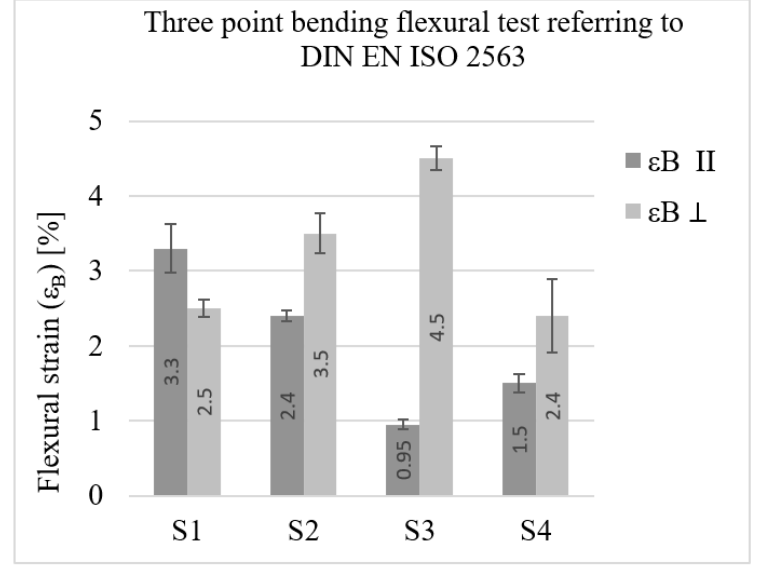
Figure 4. Apparent flexural strain ε B in the longitudinal and perpendicular directions of the tested materials.